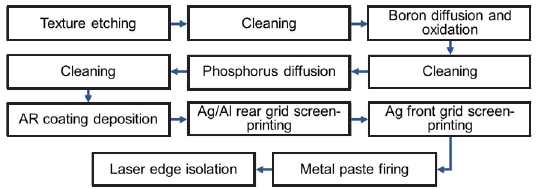
Figure 1. Fabrication process sequence of the TiO solar